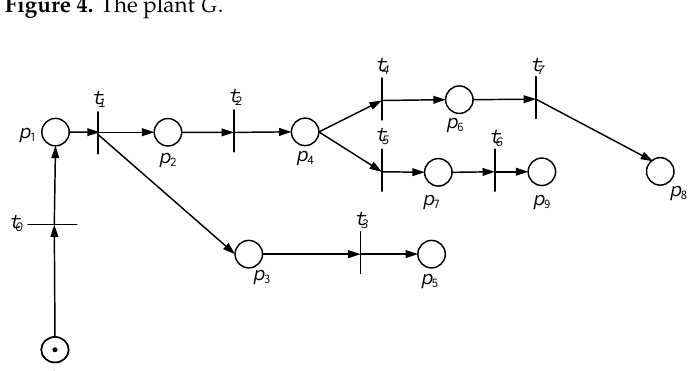
Figure 5. The supervisor H .